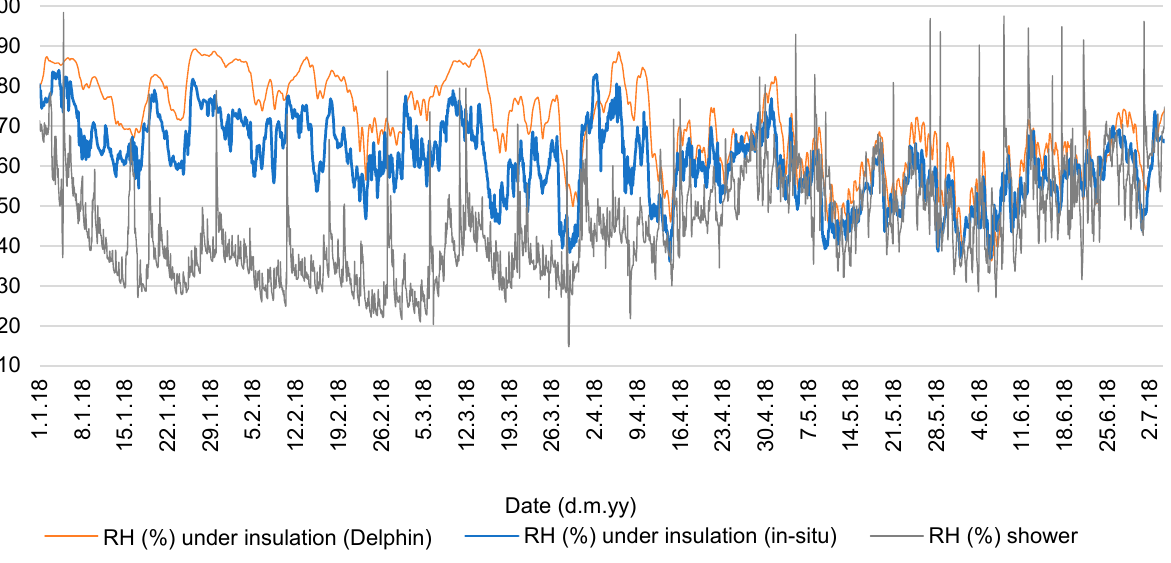
Figure 17. The temperature of the bathroom wall between the insulation and vapor barrier: measured T (blue line), simulated T (orange line), and indoor bathroom T (grey line). The bathroom measured RH between dolomite and insulation mostly stays below 80% during autumn, winter, and spring and below 70% during summer. The simulated data for the same plane shows a higher RH of up to 90% (see Figure 18).